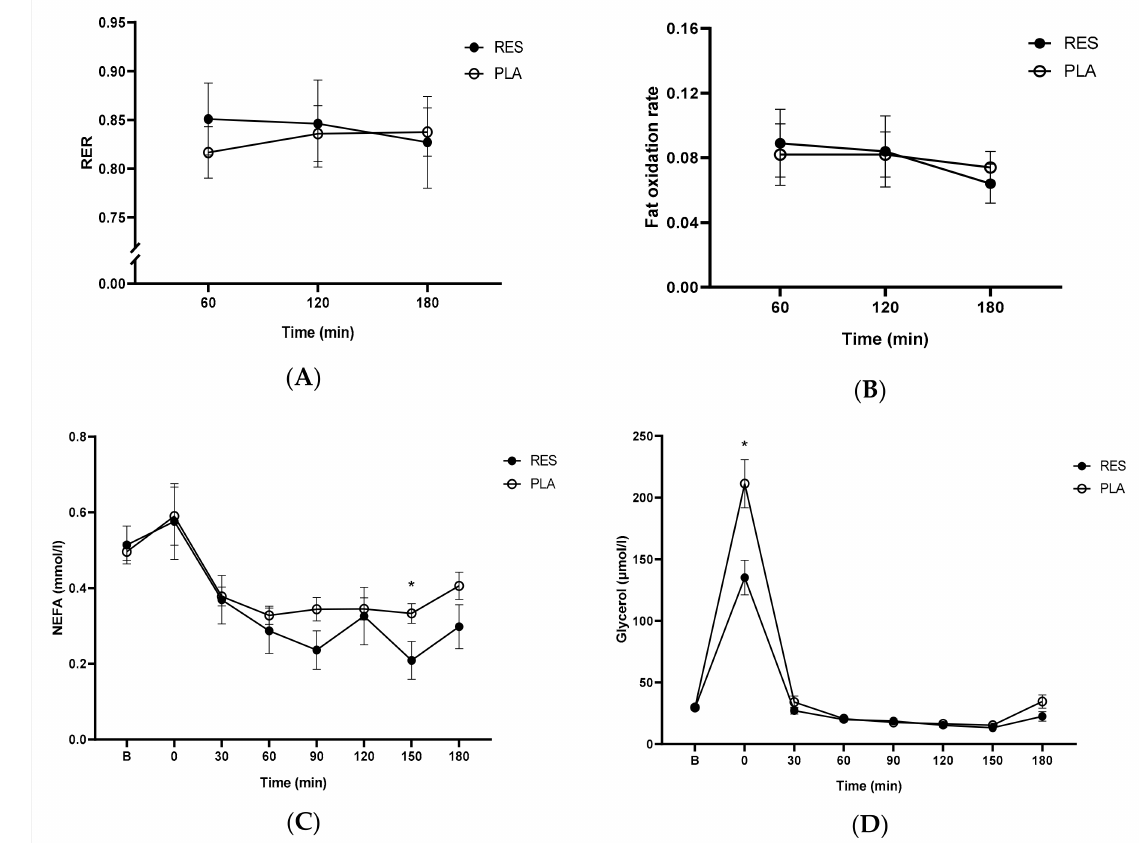
Figure 1. Respiratory exchange ratio (RER) ( A ), fat oxidation rate ( B ), non-esterified fatty acid (NEFA) ( C ) and glycerol ( D ) concentrations after a single bout of exercise in RES (- • -) and PLA (-